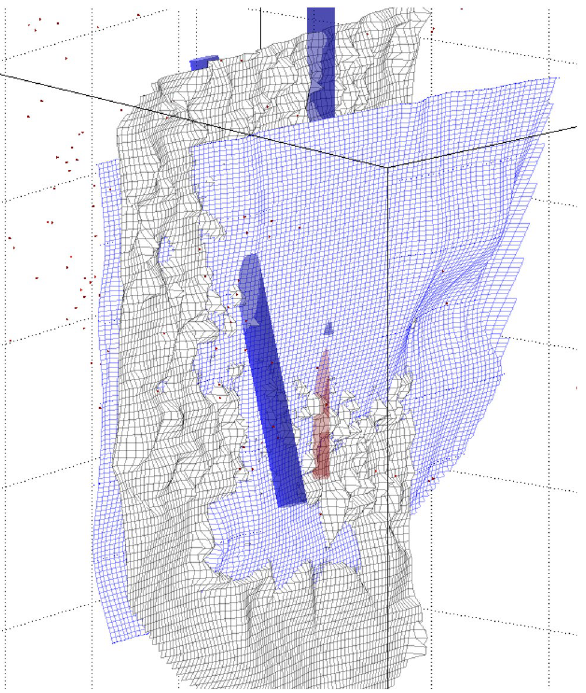
Fig. 14 Zoomed comparison between the AE predicted hydraulic fracture (black) and the digitized fracture location from the slab pho- tos